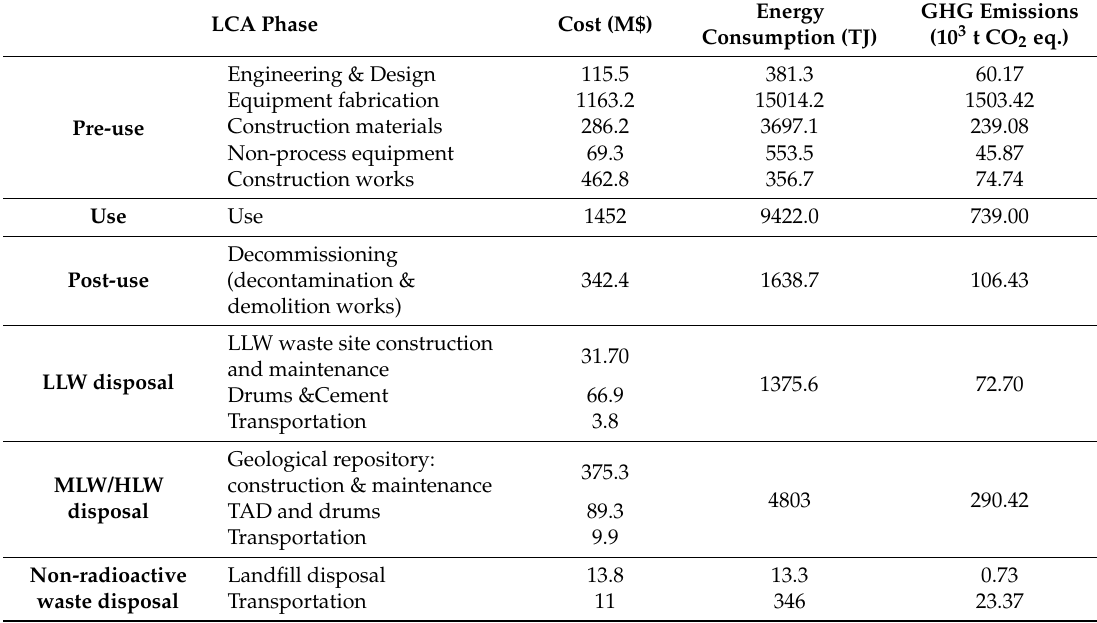
Table 5. Economic cost, energy consumption and greenhouse gas (GHG) emissions from the whole life cycle of HTGR power plant (1 GWe